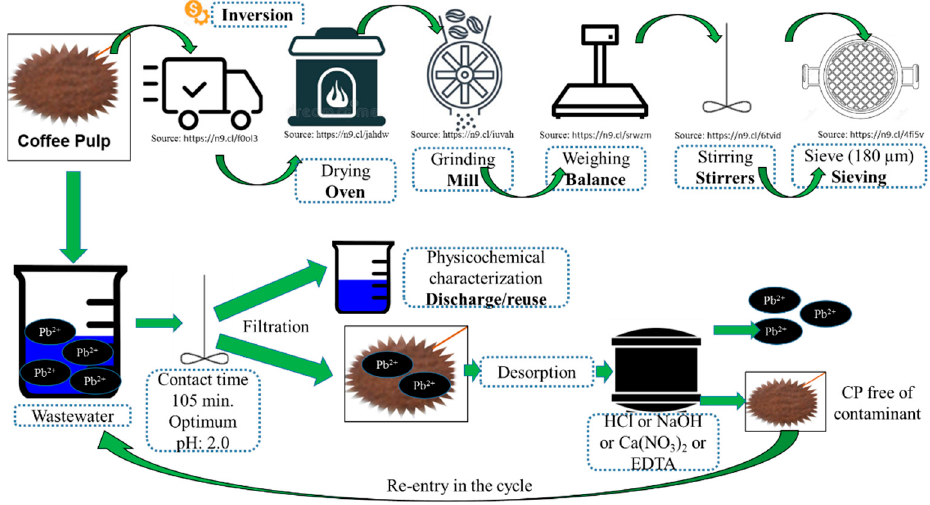
Figure 6. Stages and inputs involved in the Pb biosorption process in wastewater at the pilot